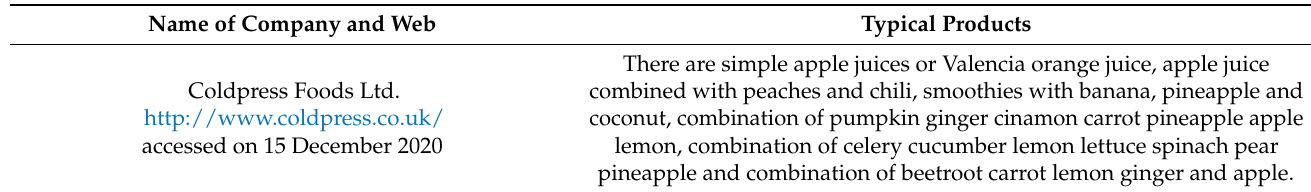
Table A4. High pressure treated products by the company Evolution Fresh.